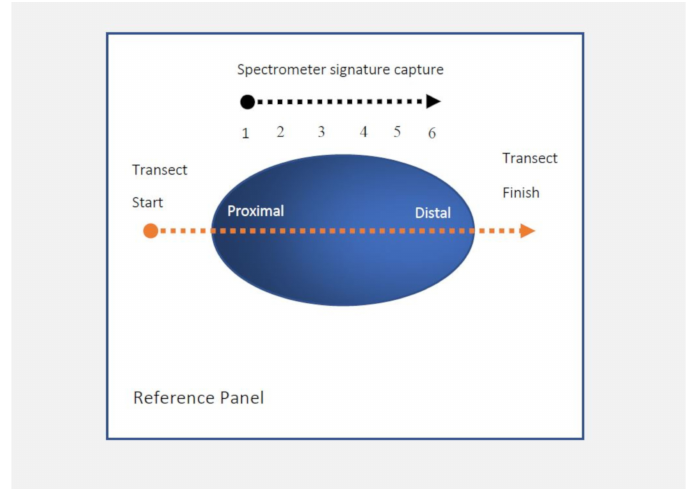
Figure 7. Transect design across the shadow footprint in Canon images. Transect start and finish direction replicate the spectrometer signature capture. Proximal (dark) and distal (light) parts of shadow